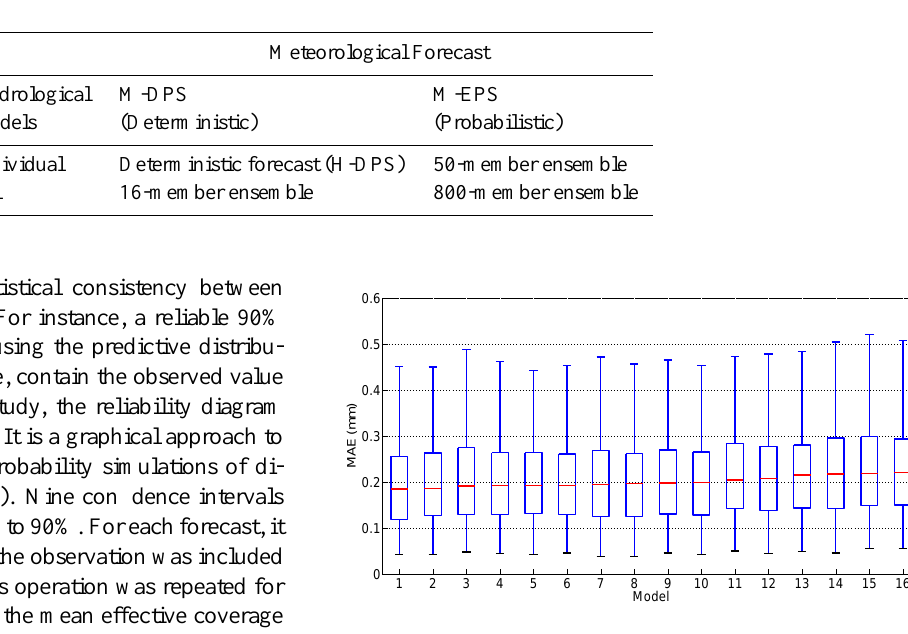
Fig. 2. Mean absolute error (MAE) calculated for the 16 lumped hydrological models and for all forecast lead times (1 to 9 days) over a 17-month period and for the 29 studied catchments. The box has lines at the lower, median, and upper quartile values (IQR) and whiskers extend to 1.5 ×